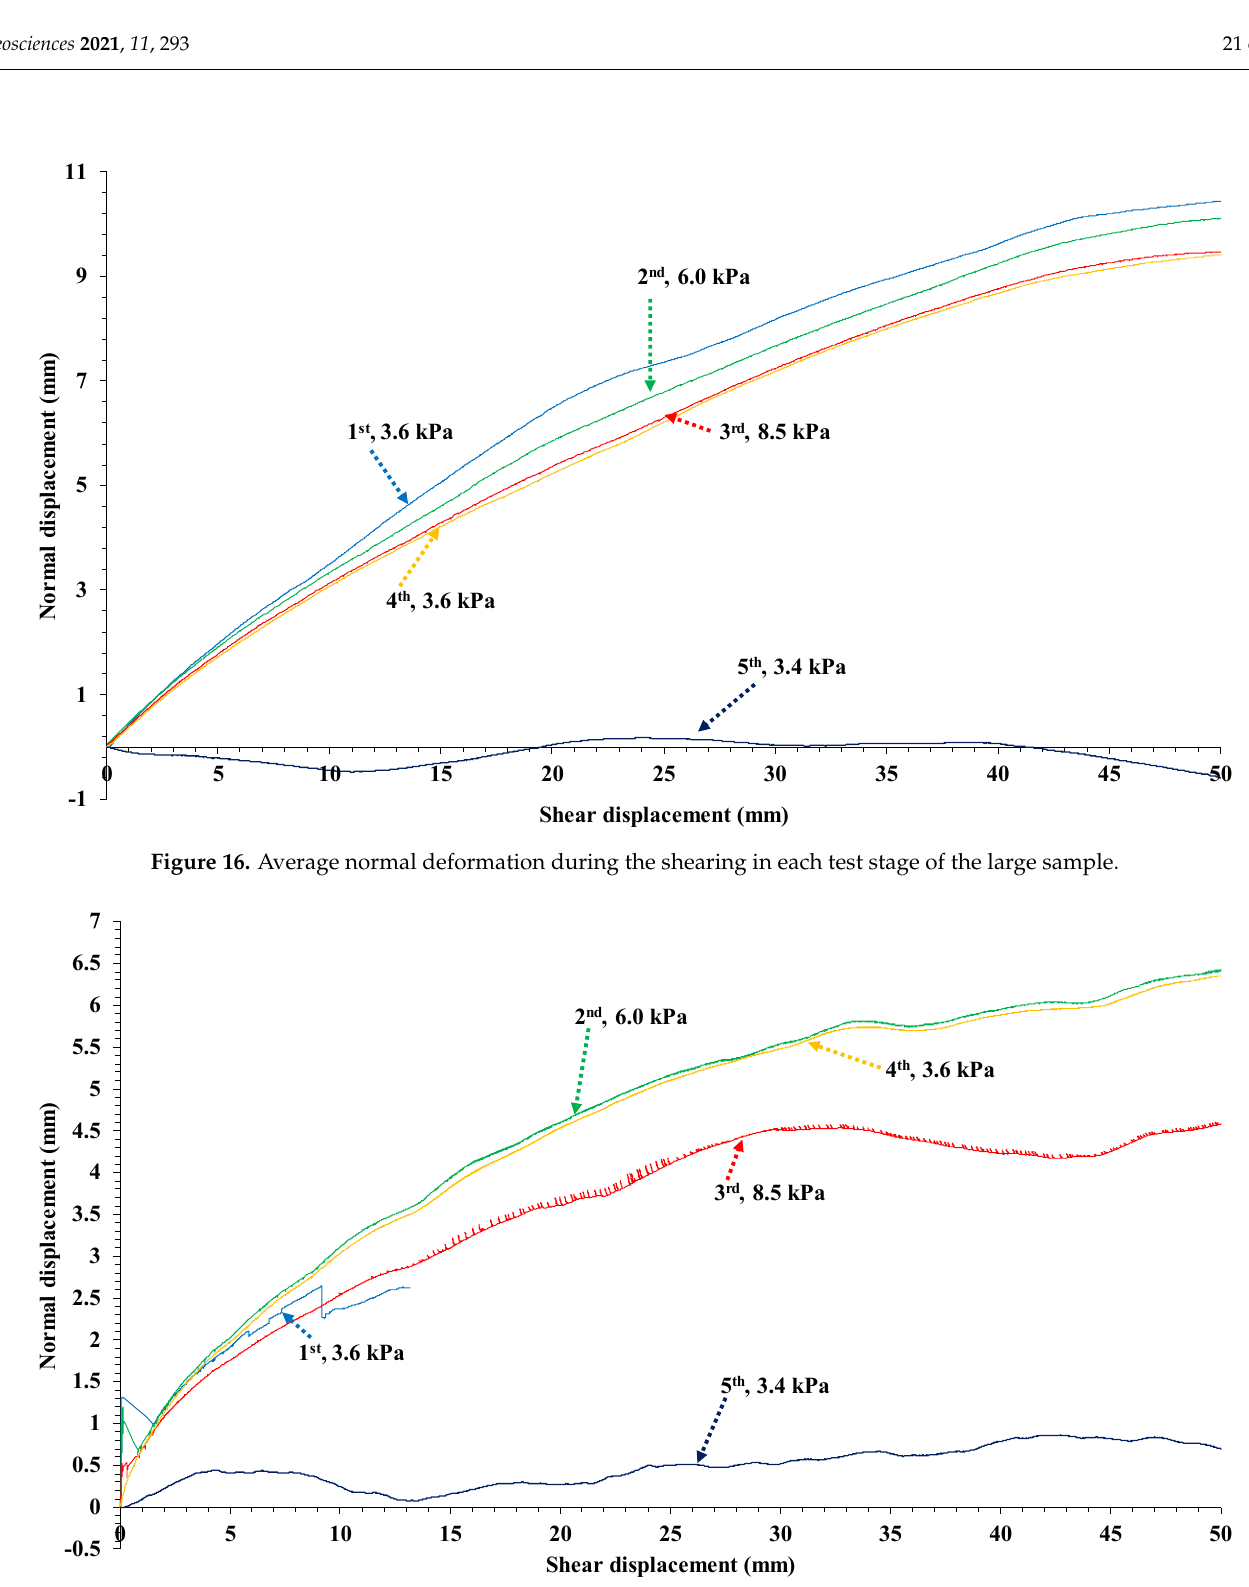
Figure 17. Average normal deformation during the shearing in each test stage of the medium sample.